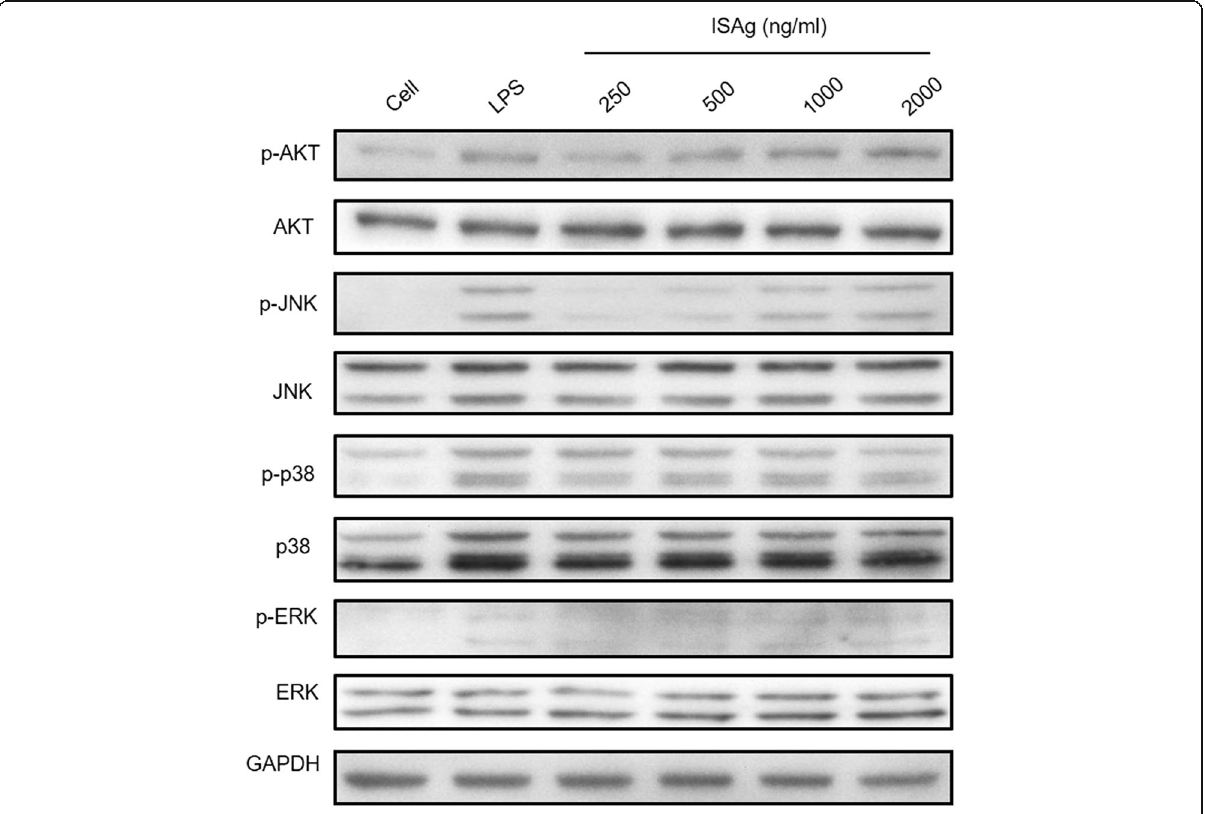
Fig. 3 The PBK/Akt and MAPK signaling pathways of macrophages were activated by ISAg treatment. Total cell lysates from RAW264.7 cells treated with LPS or ISAg were separated using SDS-PAGE gel and transferred to PVDF membranes. Phosphorylated-Akt, -JNK, -p38, and -ERK were detected using immunoblot and specific antibodies. GAPDH and the non-phosphorylated form of each protein were used as controls